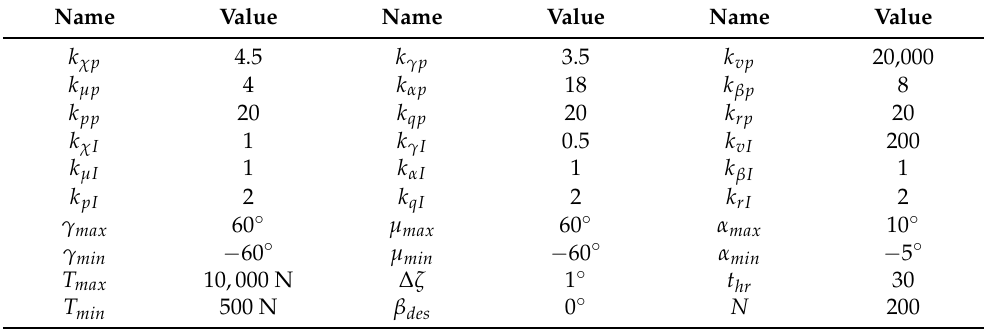
Table 1. The parameter settings of the guidance and control system and morphing module.